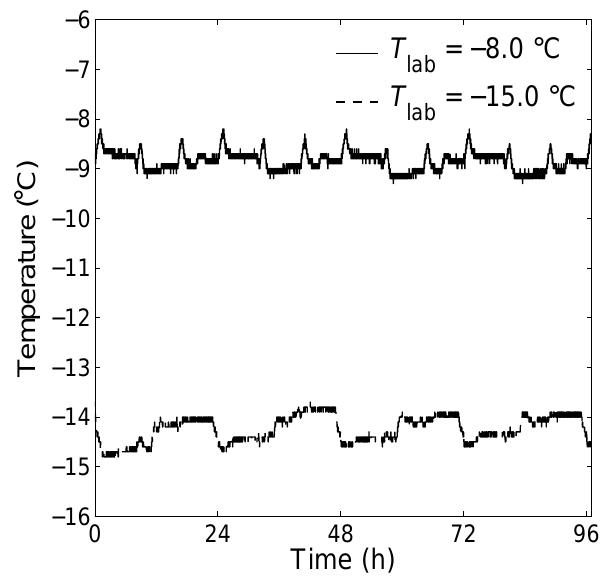
Figure 3. A typical temperature profile for experiment “sa1”, “sa2” and “sa3”, “sa4”. The temperature rise was caused by the X-ray tube and fluctuations inside the cold laboratory (Ebner et al., 2014). The accurateness of the isothermal conditions between the top and base of the sample throughout the experiment is less than 0.2 ◦ C which is still in the uncertainty of the thermistors ± 0.2K (Ebner et al.,